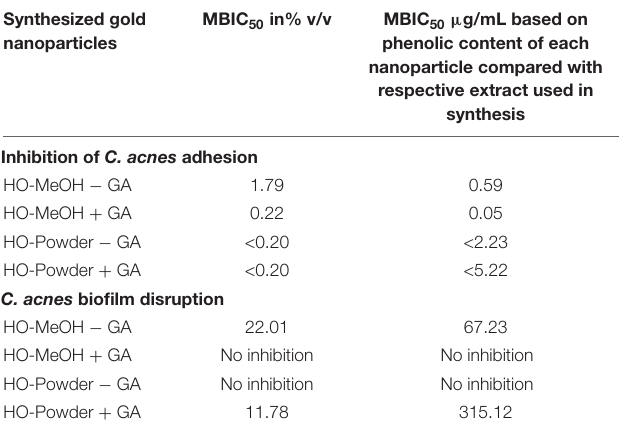
TABLE 2 | Antibiofilm activity of synthesized gold nanoparticles against Cutibacterium acnes adhesion and biofilm disruption. Synthesized gold